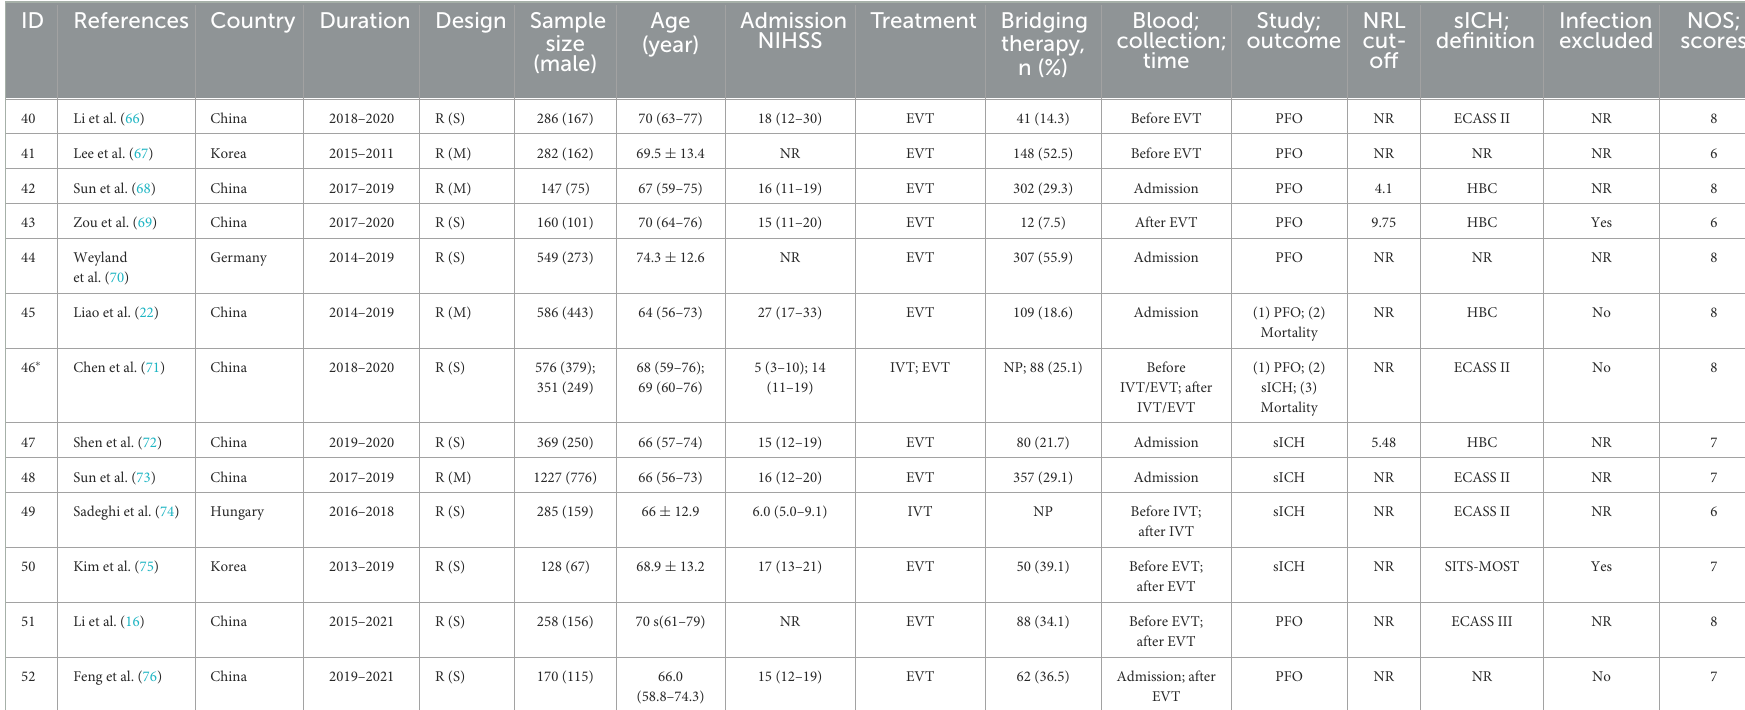
NOS, Newcastle–Ottawa Scale; NIHSS, National Institute of Health Stroke Scale; sICH, symptomatic intracranial hemorrhage; PFO, poor functional outcome; ECASS, European Cooperative Acute Stroke Studies; SITS-MOST, Safe Implementation of Thrombolysis in Stroke-MonitoringStudy; HBC,HeidelbergBleedingClassification; R,retrospectivecohort;P,prospectivecohort;S,single-center;B,dual-center;M,multi-center;NP,bridgingtherapynotperformed;NR,notreported;IVT,intravenousthrombolysis;EVT,endovascular treatment;NRL,neutrophil-to-lymphocyteratio. ∗